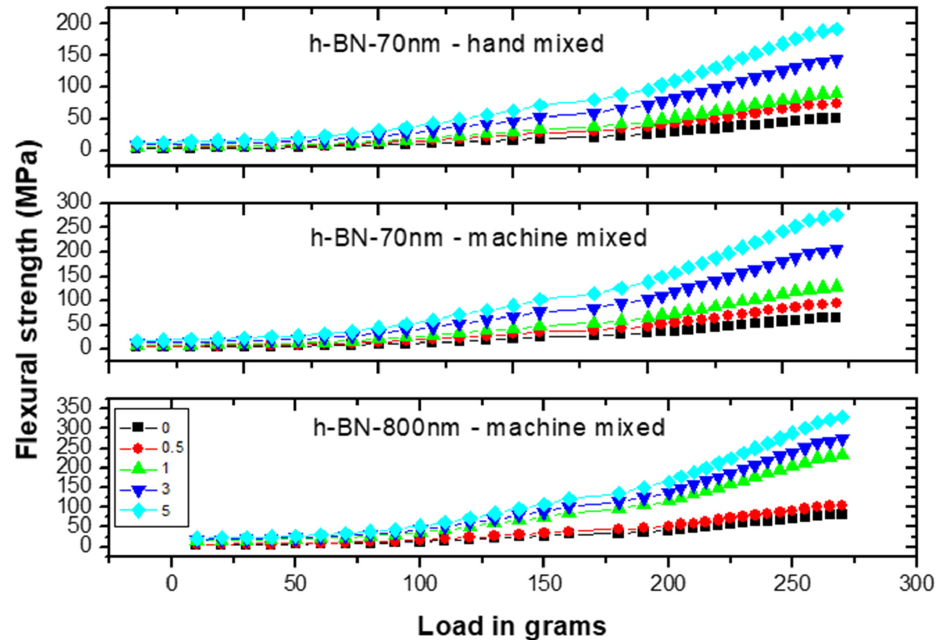
Figure 10. Flexural strength (FS) measurements versus load on specimens made by hand and ultrasonic mixing methods for 70 nm and 800 nm h ‐ BN reinforcement with different concentrations.